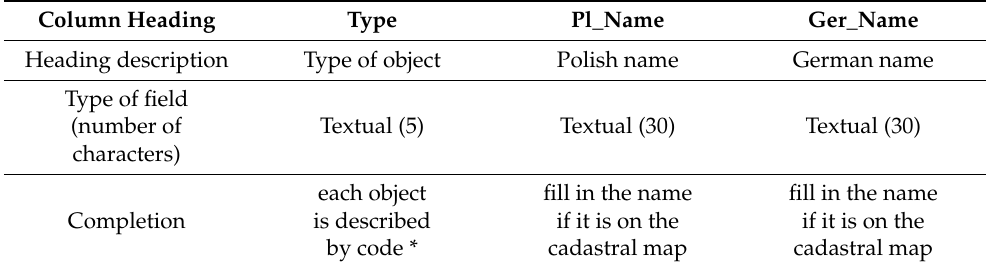
Table 3. An example of the structure and information scope for the “waters” layer including coding.